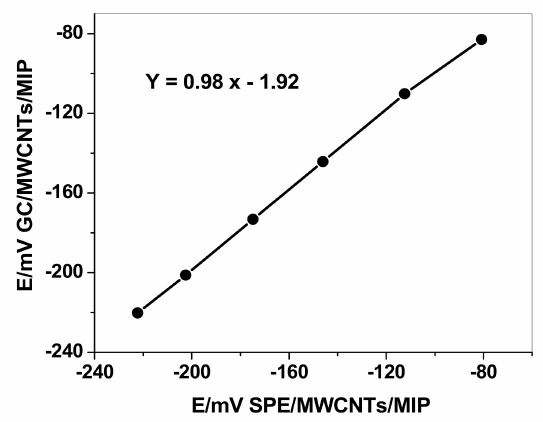
Figure 4. Comparison of potential values obtained for SPE/MWCNTs/MIP and GC/MWCNTs/MIP for different PHO